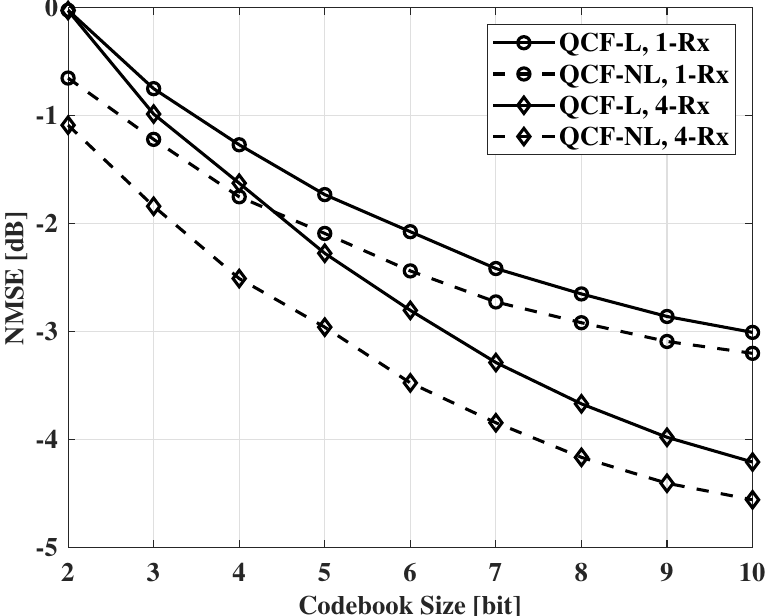
Figure 5. NMSE measurements according to codebook size, SNR = 10 dB, N t = 64, and N r =